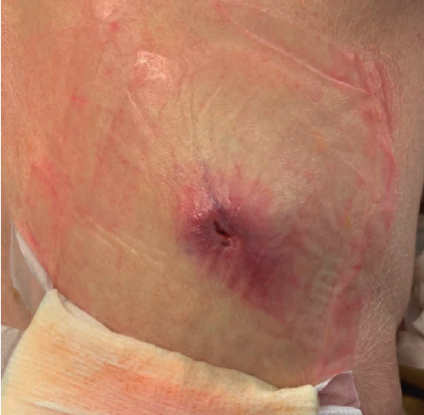
Figure 1: Right midback, nonpigmented, raised mass with the central area of erythema and serous